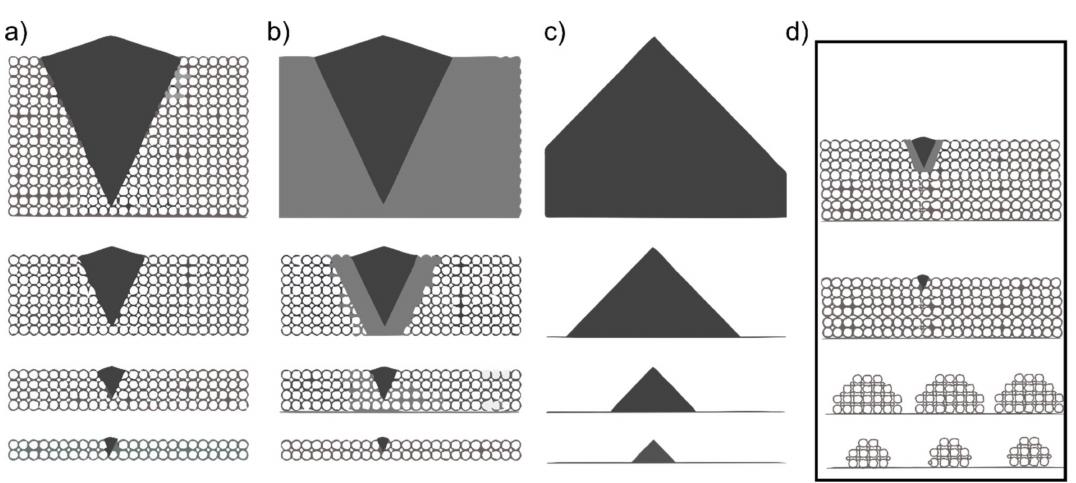
Figure 7. Schematics of di ff erent growth regimes of crystallites in ALD: ( a ) growth of crystallites from initial crystalline nuclei in an amorphous film; ( b ) growth of crystallites from initial crystalline nuclei in an amorphous film, inducing crystallization of the amorphous region next to the crystallite; ( c ) growth of the ALD layer directly from crystalline nuclei, in an island growth-like regime; ( d ) growth of the ALD layer in island growth-like regime starting from an amorphous material and developing crystallinity after the completion of a continuous layer. (a) to (c) were adapted from